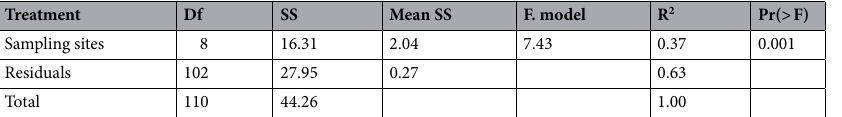
Table 4. Permanova results based on Bray–Curtis dissimilarities evaluating differences in the bacterial community composition between Aedes japonicus , Aedes triseriatus , water samples at each individual sampling site at Trelease Woods study location. P -values are based on 999 permutations.